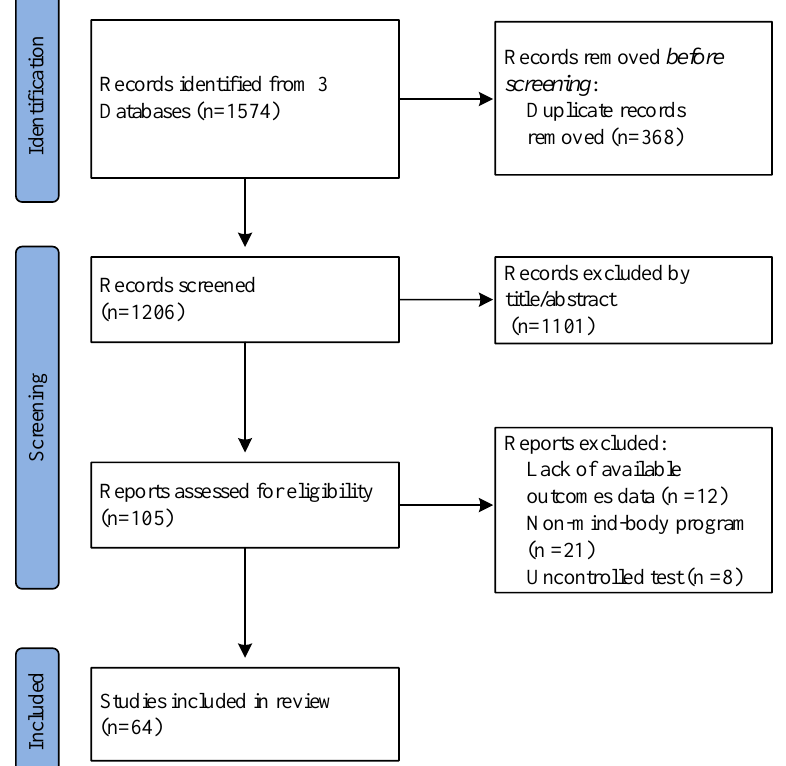
Figure 1. The detailed process of trial selection.